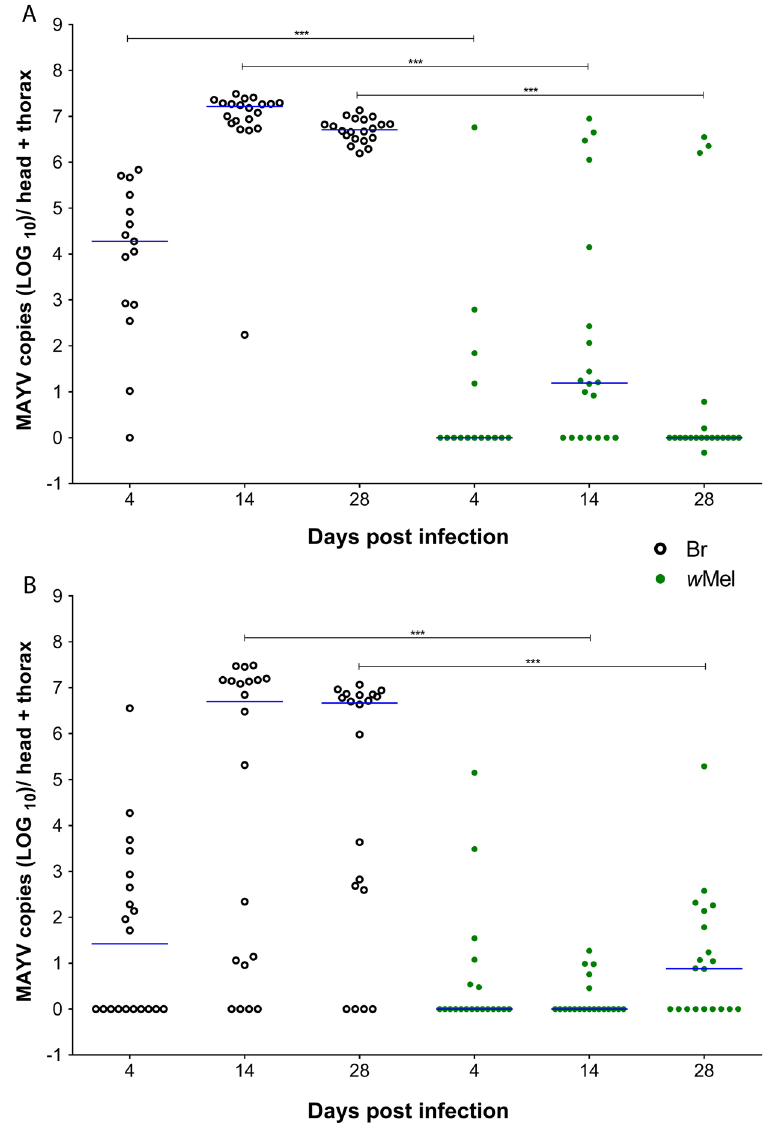
Figure 3. Susceptibility of Aedes aegypti and the ability of Wolbachia to block MAYV. ( A , B ) Mosquitoes were orally challenged with either ( A ) fresh virus or ( B ) frozen virus samples. Br mosquitoes (black circle) and w Mel Wolbachia (green circle). Each circle represents a single adult female, and the blue lines indicate the median number of MAYV copies in each treatment. ∗∗∗ P < 0 . 0001 ; Mann-Whitney U test.